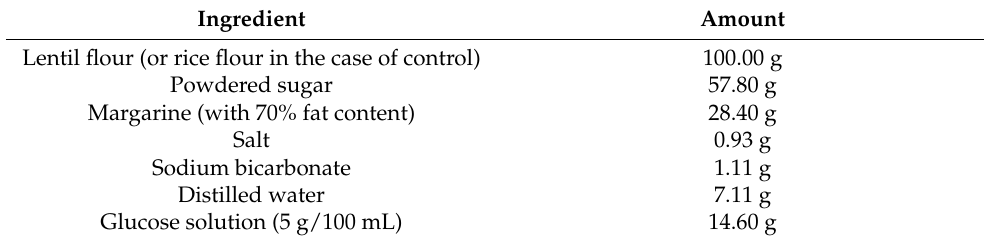
Table 1. Cookie recipe.